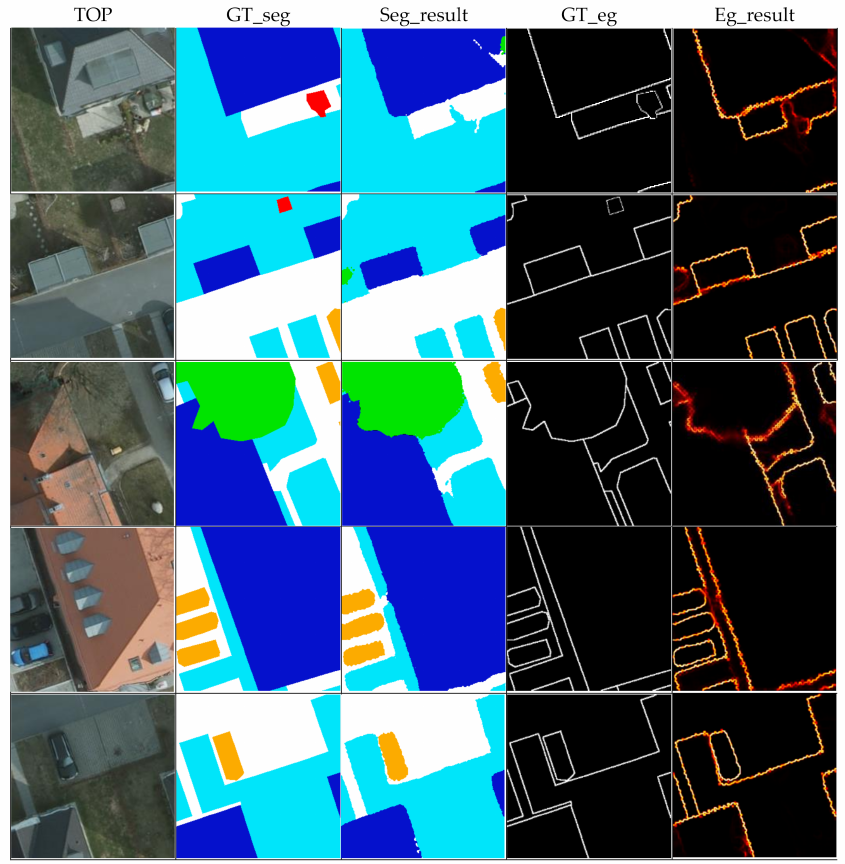
Figure 11. Examples of semantic segmentation and edge detection results using the “RS+Edge+ DNL LAST ” method, based on the Potsdam dataset. Each column from left to right is the TOP, segmentation ground truth, segmentation result, edge ground truth and edge detection